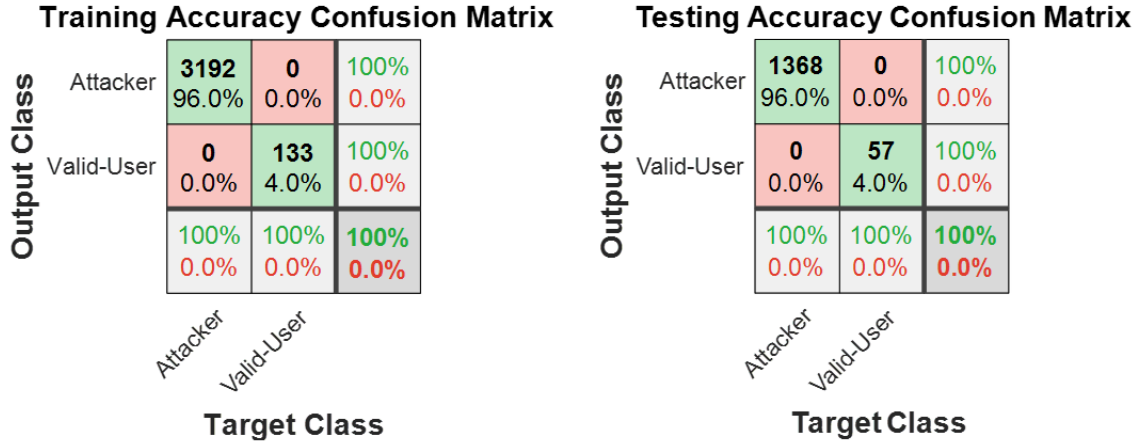
Figure 9. Phase two experiment confusion